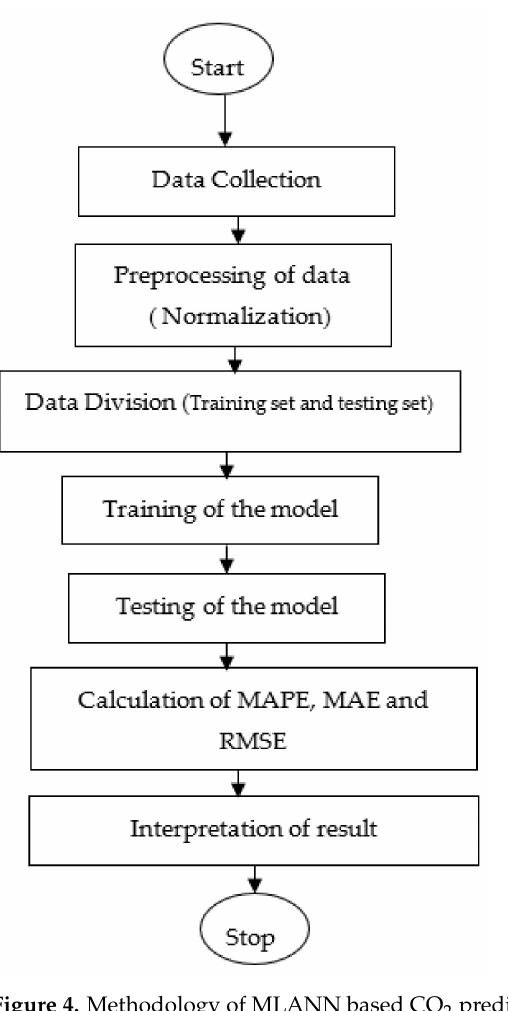
Figure 4. Methodology of MLANN based CO 2 prediction model.